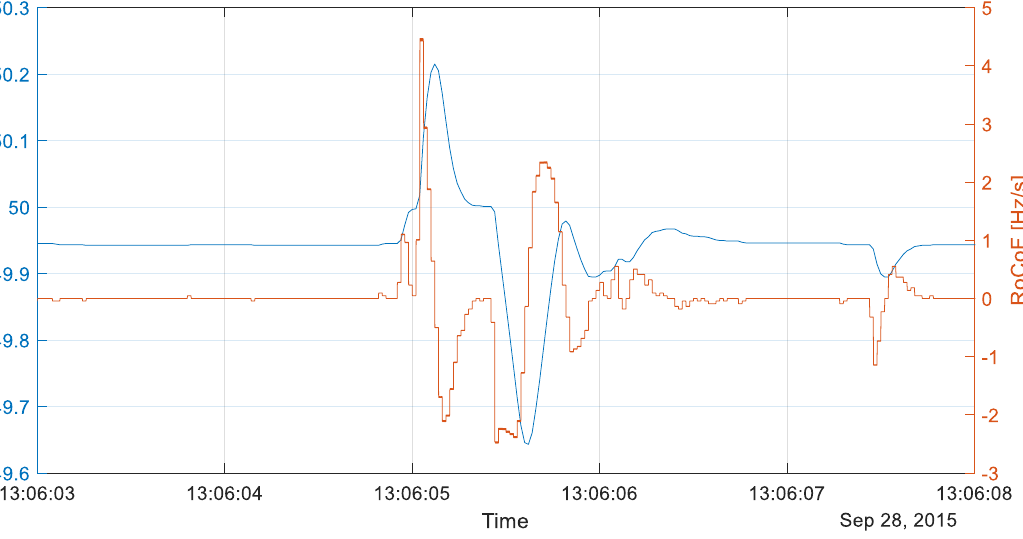
Figure 5. Example for an event of the grid frequency during which the RoCoF threshold is violated several times in a short period.